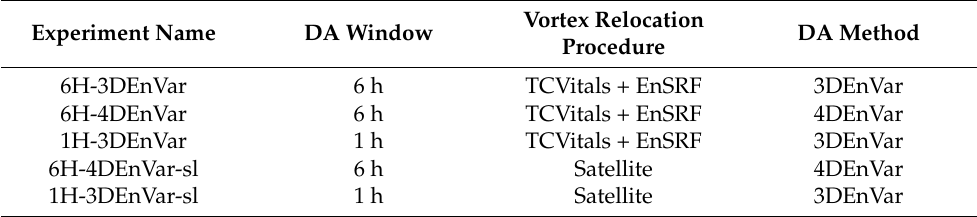
Table 4. Table of